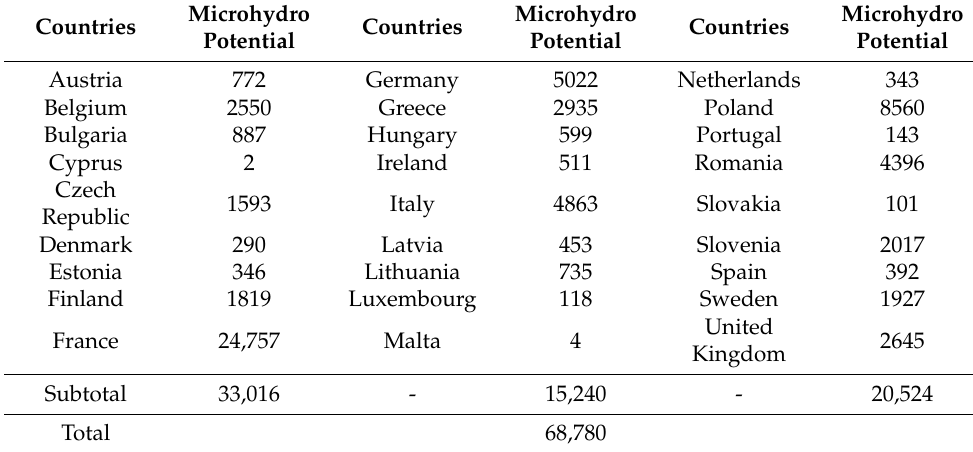
Table 10. Microhydro potential in Europe as of 3 January 2021, cataloged as part of the RESTOR Hydro project. Number of objects included in the unused hydrotechnical infrastructure that could constitute a material basis for the construction of micro and small hydropower plants (estimation of the lower limit with nameplate capacity: 68,780 × 40 kW = 2751.2